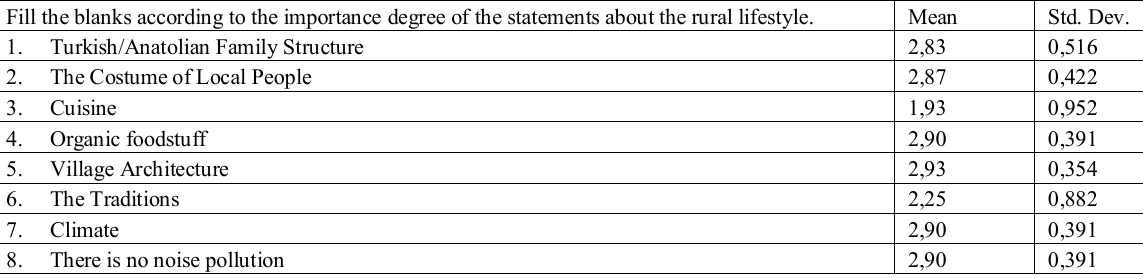
Table 4: Analysis of how were the participants affected by village life in Beysehir Fill the blanks according to the importance degree of the statements about the rural lifestyle.